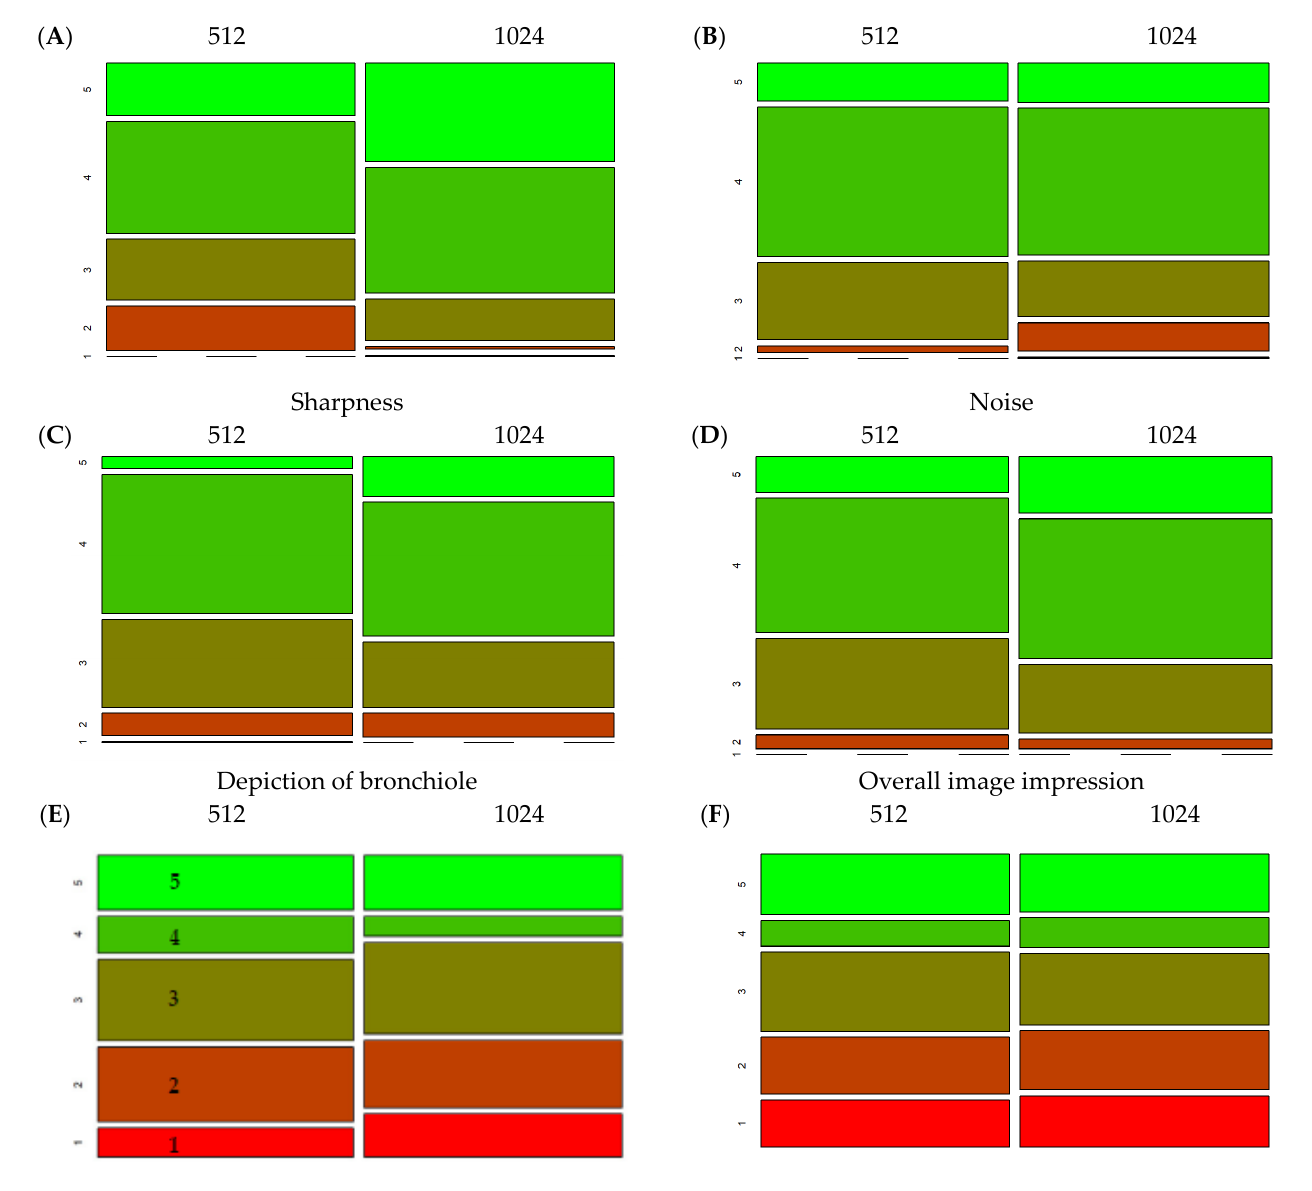
Figure 2. Violin plot: Total score per Matrix size (resolution) 512 and 1024 (mean for all 4 raters).